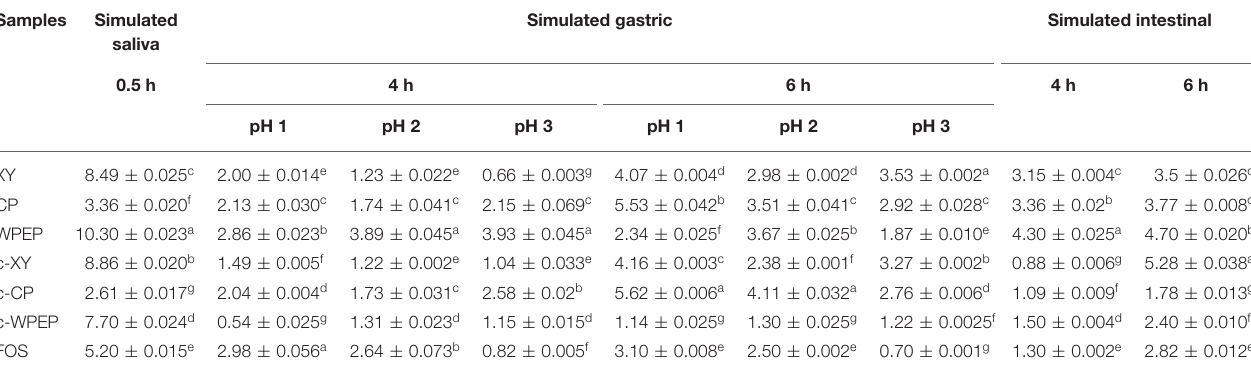
TABLE 2 | Hydrolysis degrees (%) of polysaccharides in simulated salivary, gastric, and intestinal conditions. Samples Simulated Simulated gastric Simulated intestinal saliva